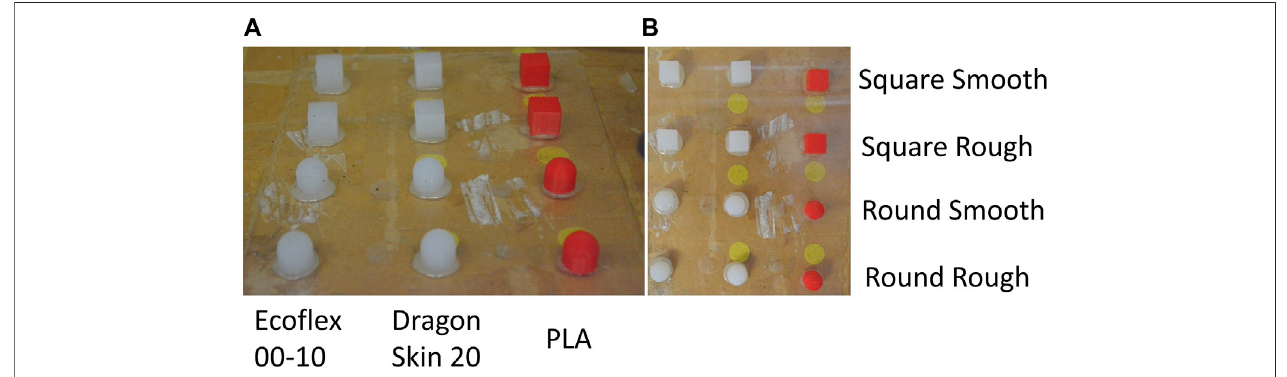
FIGURE3| Sideview (A) andtopview (B) ofdifferentobjectsusedforthedataacquisition.Fromlefttoright:Eco fl ex00 – 10,DragonSkin20,andPLA.Fromtopto bottom: Smooth Square, Rough Square, Smooth Round, and Rough Round.